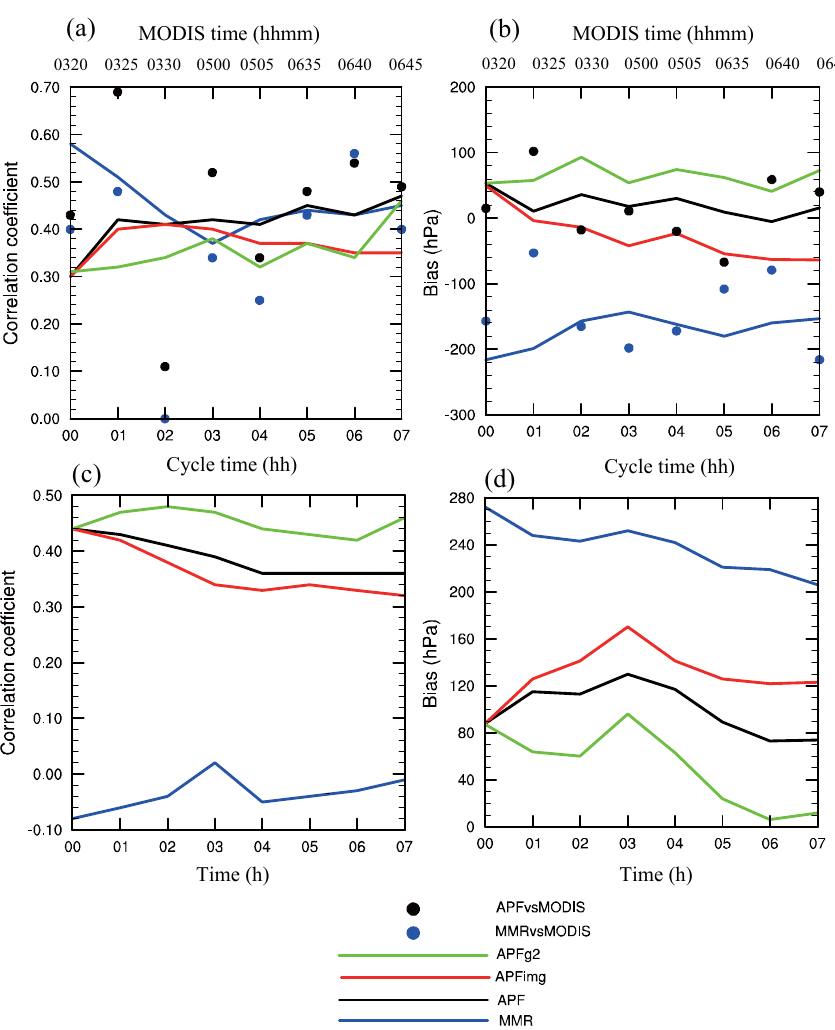
Figure 9. (a) Correlation coefficient, (b) bias for the cloud top pressure, (c) correlation coefficient and (d) bias for the cloud bottom pressure vs. the NASA GOES retrievals from 06:00UTC, 15 December 2013, to 07:00UTC, 15 December 2013. Black and blue dots denote results vs. the MODIS level 2 cloud top pressure retrieval valid at 03:20, 03:25, 03:30, 05:00, 05:05, 06:35, 06:40 and 06:45UTC. The valid times for the MODIS level 2 data are shown on the top of the x